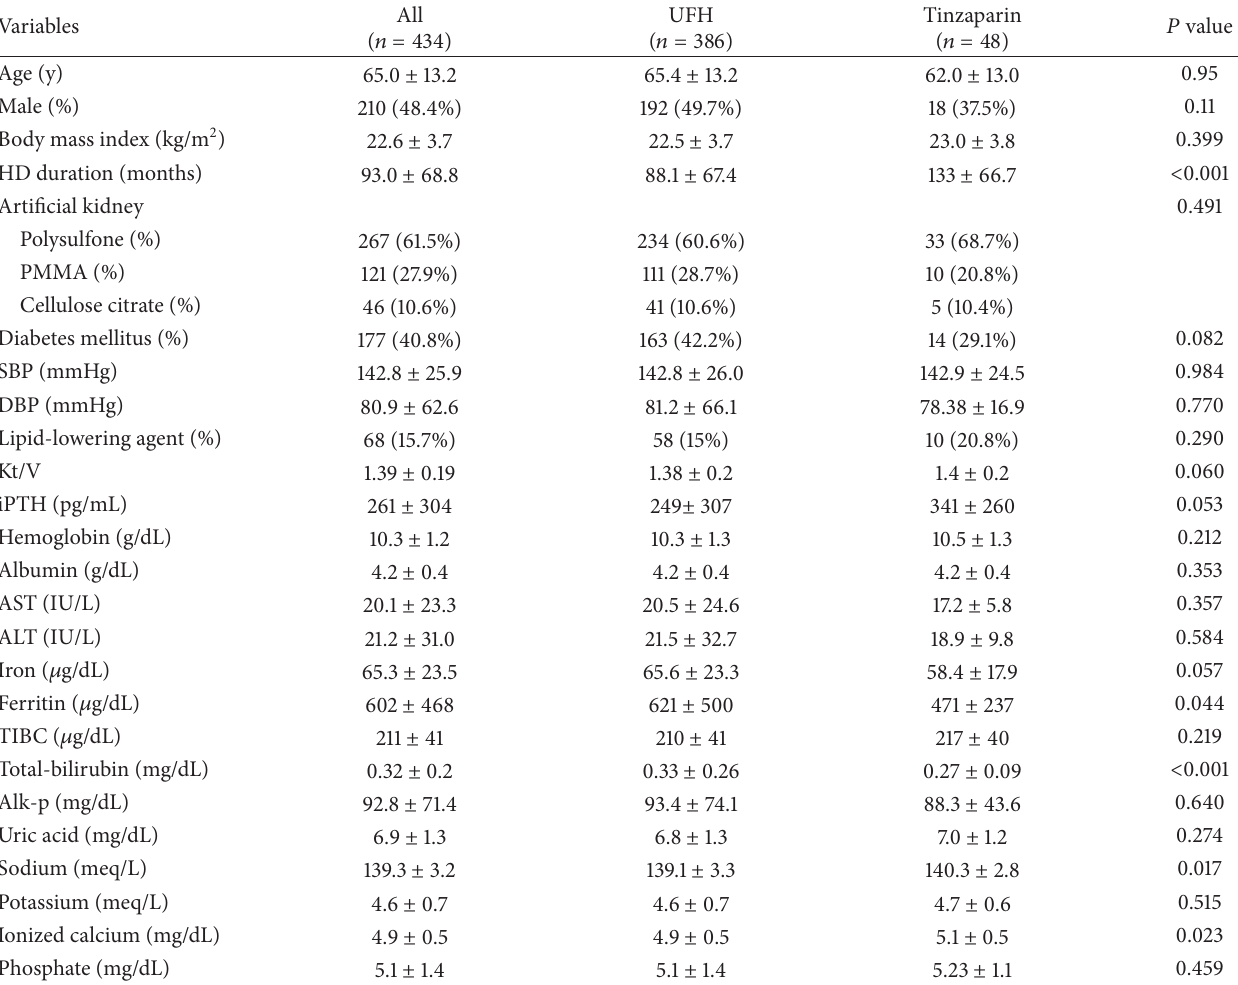
Table 1: Demographic and clinical data stratified according to the use of tinzaparin and unfractionated heparin.